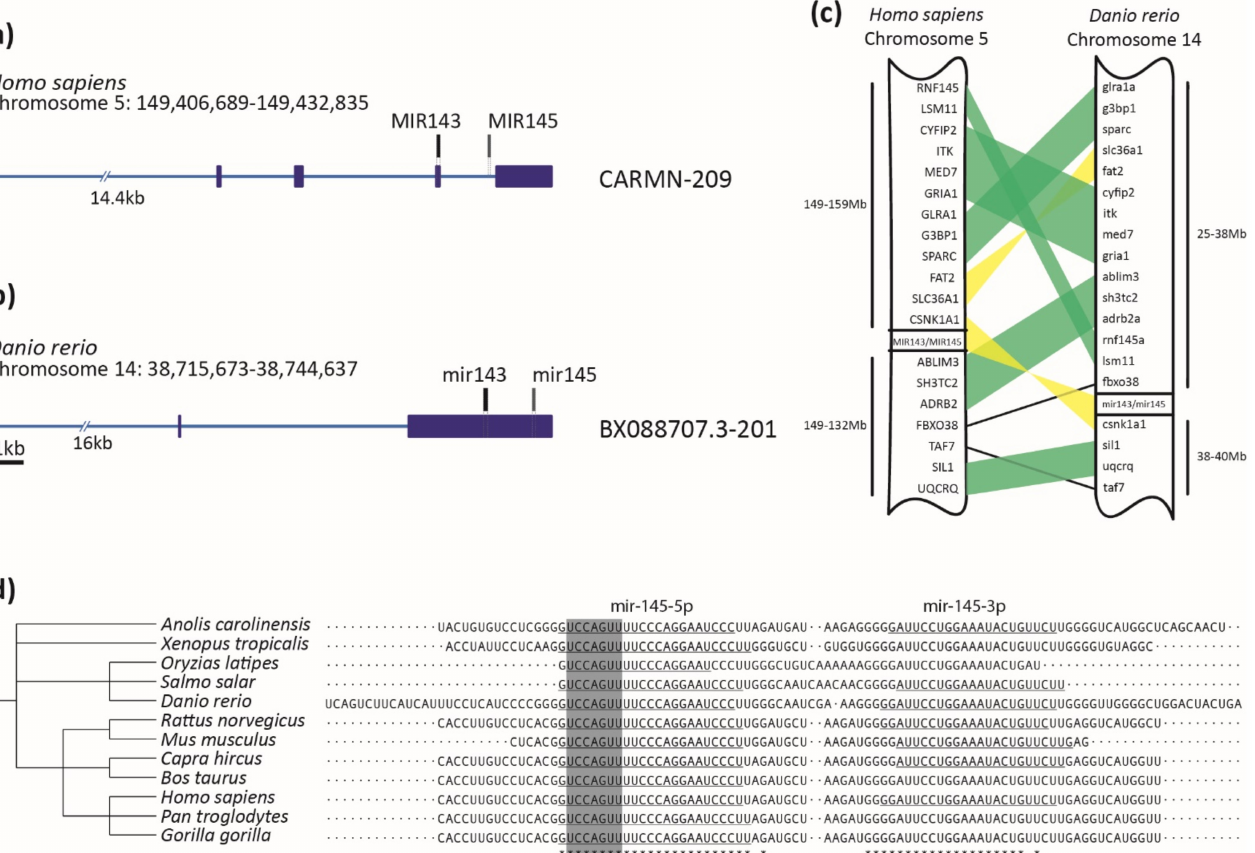
Figure 1. MiR-145 is highly conserved across vertebrates. ( a , b ) Homo sapiens CARMN-209 and Danio rerio BX088707.3-201 transcripts containing miR-143 (in black) and miR-145 (in gray) precursors. Exons are represented with dark blue boxes and introns with light blue lines. Scale bar represents 1kb. ( c ) Schematic representation of synteny analysis of miR-143/miR-145 cluster between Homo sapiens and Danio rerio. Blocks of genes in the same order are highlighted in green, while those blocks that are inverted are in yellow. Only conserved genes are shown. ( d ) Clustal Omega alignment of miR-145 precursor, displaying taxonomic tree on the left and aligned sequences on the right. Asterisks at the bottom represent 100% conserved bases. The mature miR-145-5p sequence is underlined on the left, with the seed sequence highlighted in gray. Some species that also possess annotated mature miR-145-3p are underlined on the